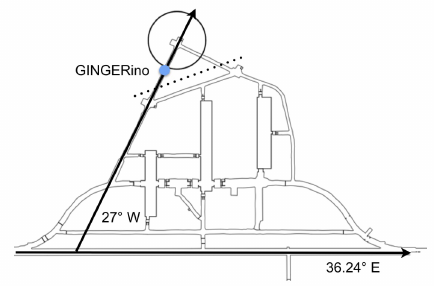
Figure 1: Map of the LNGS underground laboratories